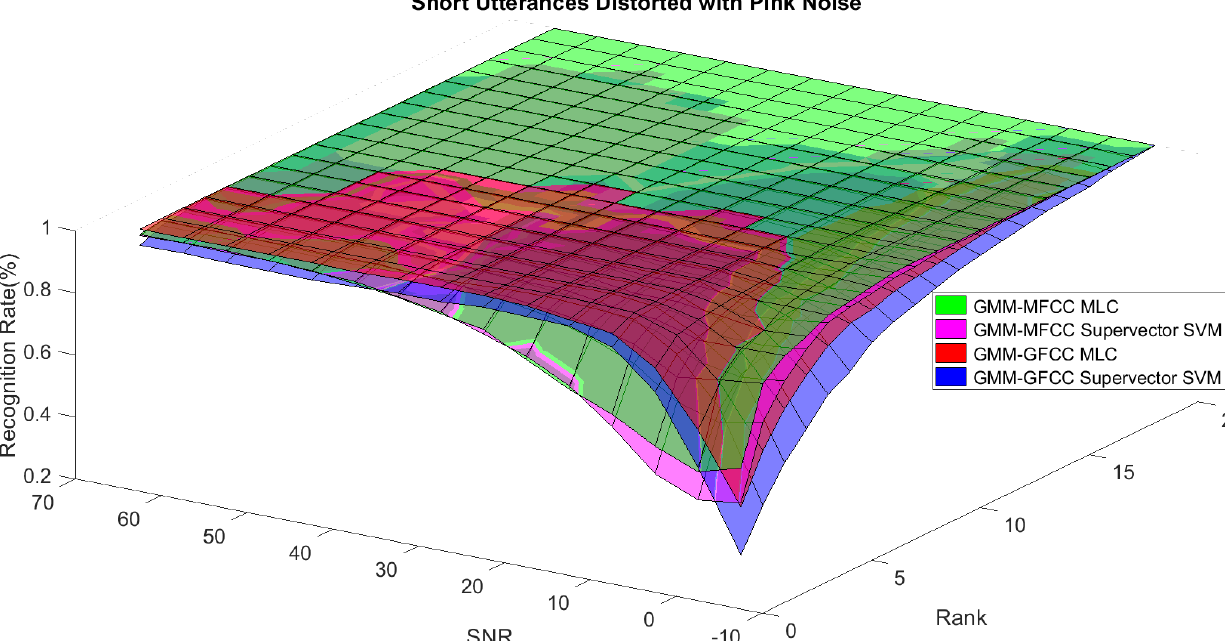
Figure 13. The 3D surface of the recognition rates for the base classifiers on short utterances distorted with pink noise.